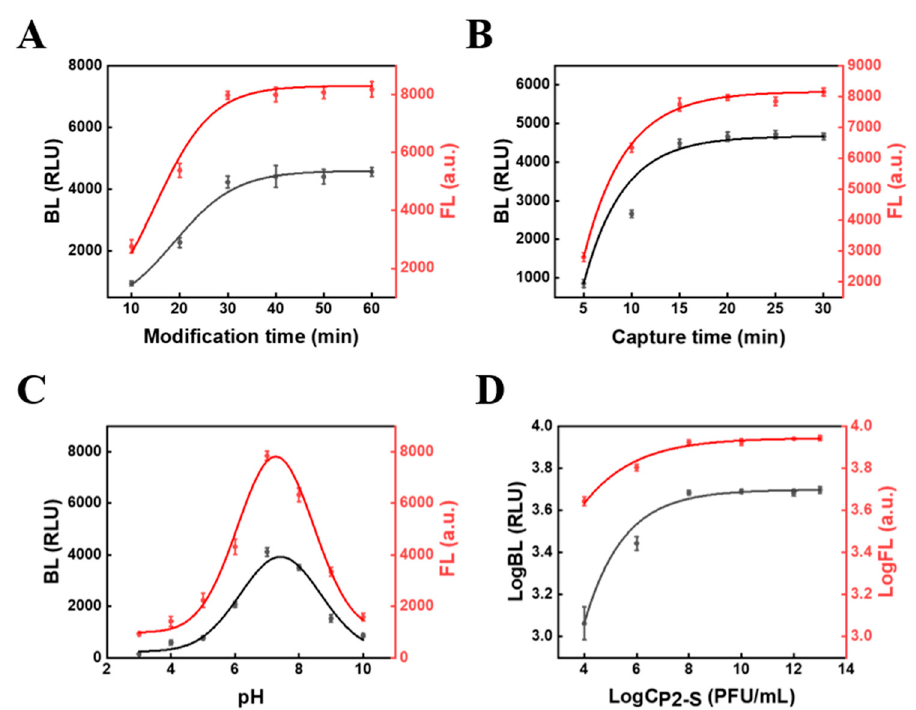
Figure 4. The condition optimization of ( A ) the modification time between P1 and MB@PDDA, ( B ) the time for phage to capture S.T, ( C ) pH, ( D ) and the concentration of P2-S (the concentration of MB was 1 mg/mL). The concentration of S.T was 10 8 CFU · mL − 1